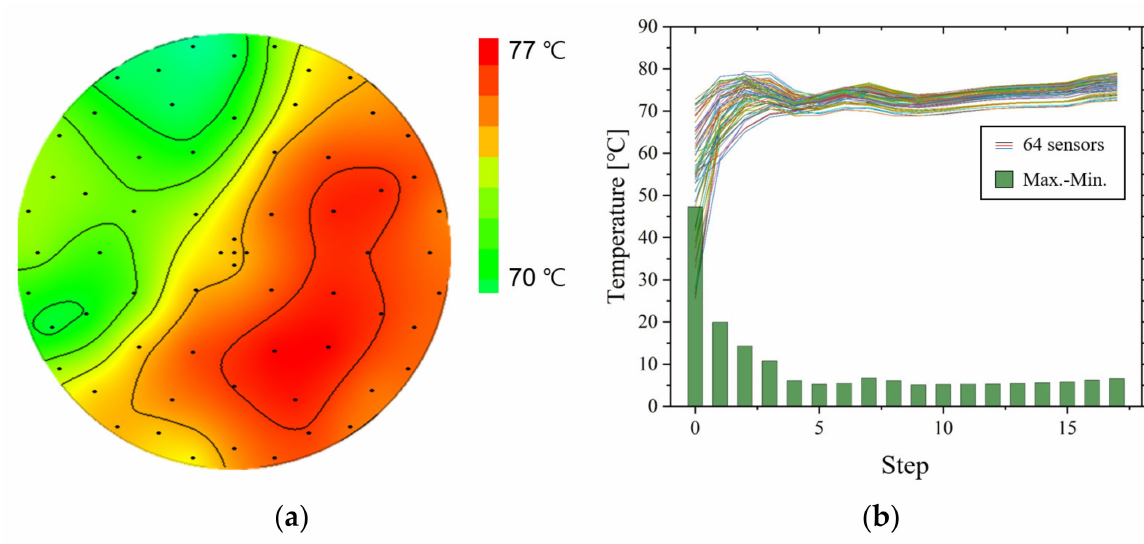
Figure 9. Abnormal ESC temperature distribution measurement distribution diagram: ( a ) heat map and contour map and ( b ) temperature measurement